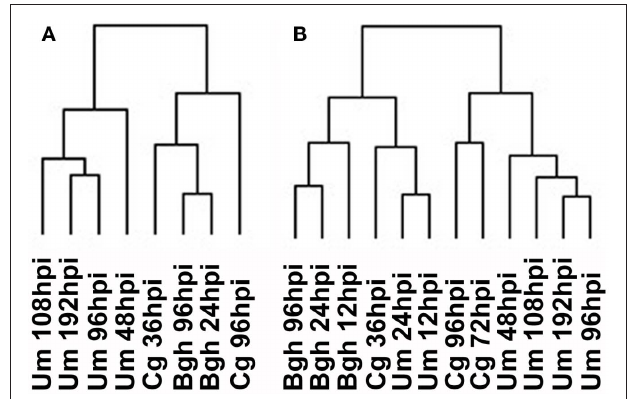
Figure 5 | Hierarchical cluster analysis of whole transcriptome data. (A) HCA for the timepoints analyzed in this report. (B) HCA for all timepoints sampled. Barley and maize Affymetrix data were matched via PlexDB (www. plexDB.org) as described in the methods section and the mean transcript fold changes of infected vs. mock samples were calculated based on all three replicate experiments and were subsequently used for HCA. After log transformation of the data, median centered data were normalized and hierarchical clustering analysis (HCA) was performed using the complete linkage algorithm of the program Cluster v2.11 (Eisen et al., 1998 – www. eisenlab.org) and the results were visualized using Maple Tree (http:// mapletree.sourceforge.net/). Bgh, Blumeria graminis f.sp. hordei ; Cg, Colletotrichum graminicola ; Um, Ustilago maydis; hpi, hours